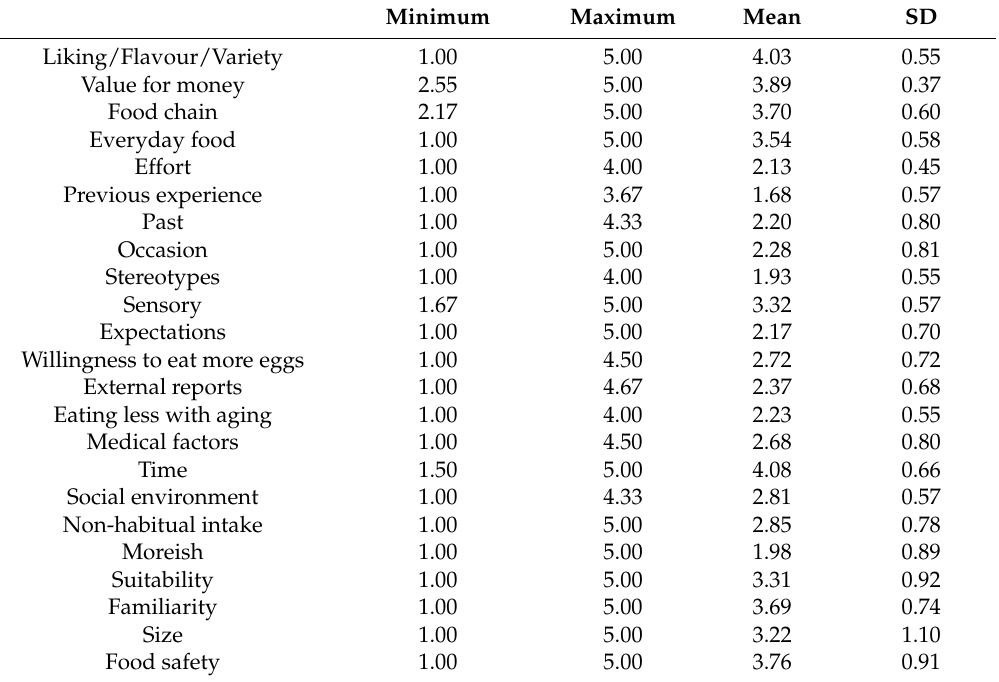
Table 3. Minimum, maximum, mean and SD for each component for all participants ( n = 230). Component scores were converted to scores ranging 1–5, to allow comparability with the initial questionnaire response format and coding.